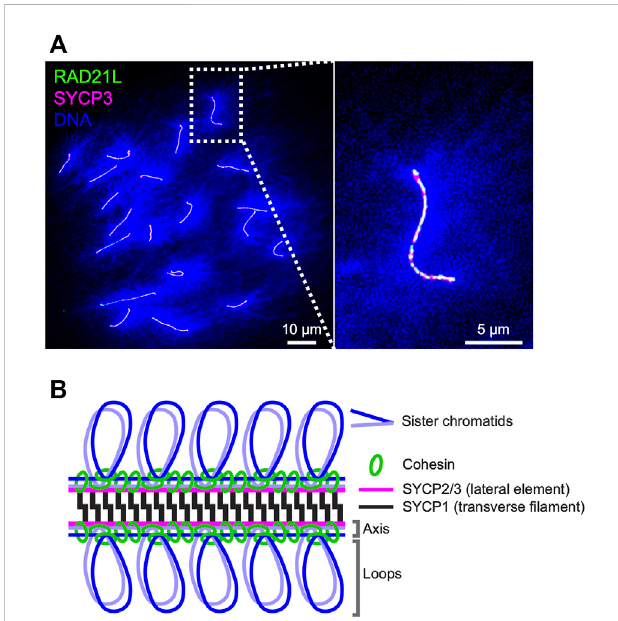
FIGURE 1 Axis-loop chromosome structure and the synaptonemal complex in mice (A) Surface spreads of mouse oocyte pachytene chromosomes immunostained for RAD21L (green), SYCP3 (magenta), and DNA (DAPI; blue). DNA is condensed on chromosome axes where cohesin complexesandaxiscoreproteinslocalizeandspreadasloopsfromaxes. RAD21LandSYCP3areshownasarepresentativeofmeioticcohesinand axis core protein, respectively (B) Schematic representation of the mouse synaptonemal complex. Cohesin complexes interconnect axes of sister chromatids and lateral elements SYCP2 and SYCP3 and a transverse fi lament protein SYCP1 form a ladder/zipper-like